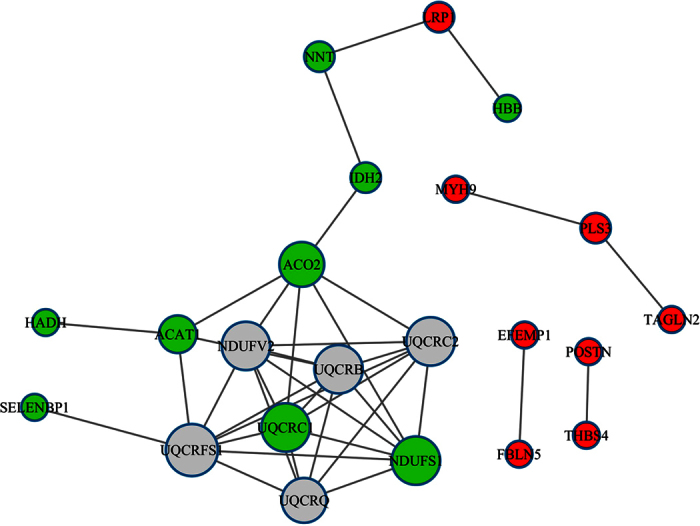
Functional protein interaction networks.The network of interactions of the 19 differentially expressed proteins between gastric cancer and adjacent normal gastric tissue was predicted using the String data base. Red: up regulated proteins; green: down regulated proteins; grey: other related proteins.